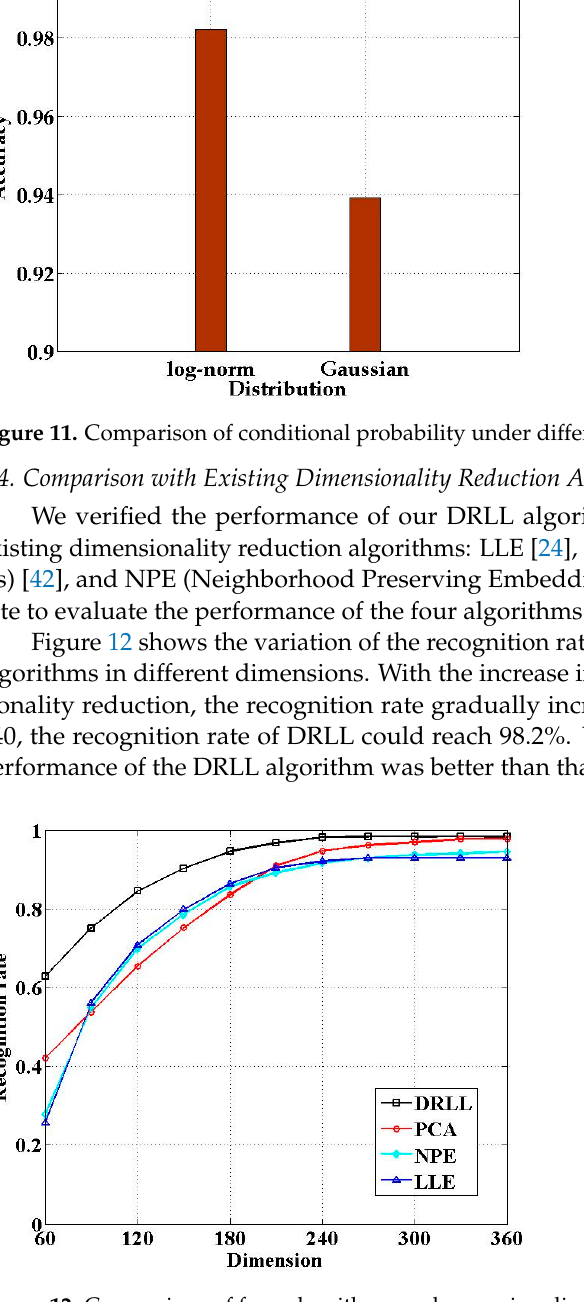
Figure 10. Comparison of classification sample in different dimensions.